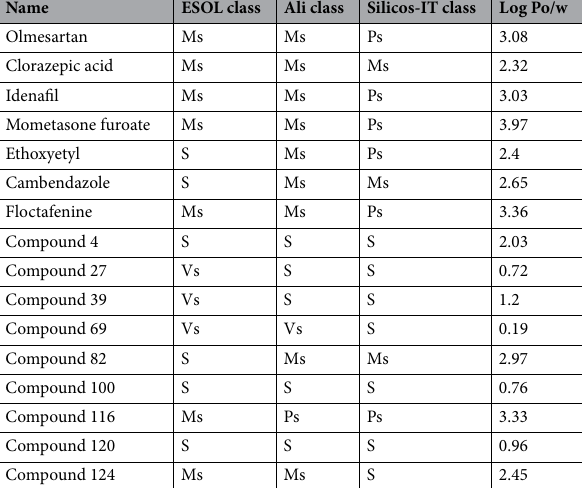
Table 5. Properties calculated from ADME, solubility (S = Soluble, Ms = Moderately soluble, Ps = Poorly soluble), and log Po/w